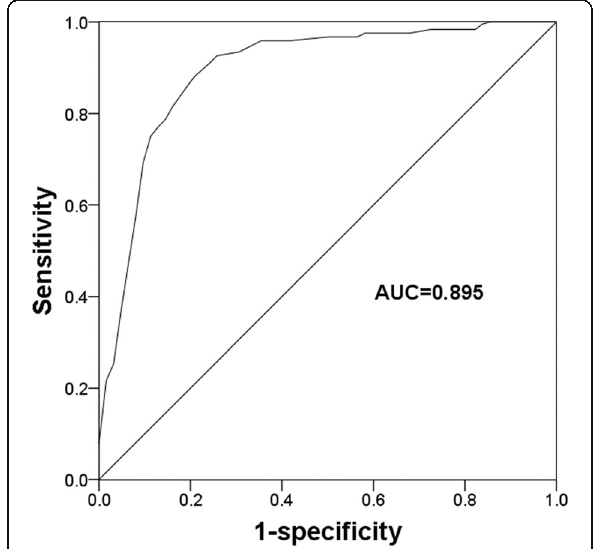
Fig. 2 A ROC curve constructed based on serum miR-92a in ACAS patients and healthy individuals. AUC, area under the